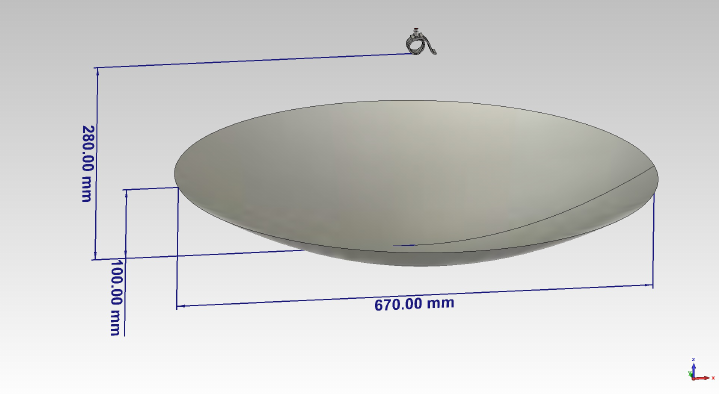
Figure 3. Model of the focusing component of the system for measuring the electrophysical properties of